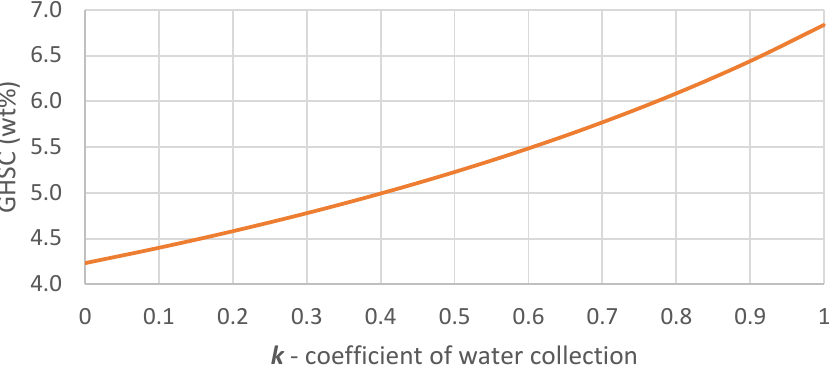
Figure 2. GHSC of the initial SBH–water mixture as a function of k for hydrogen generator with x = 6.4.